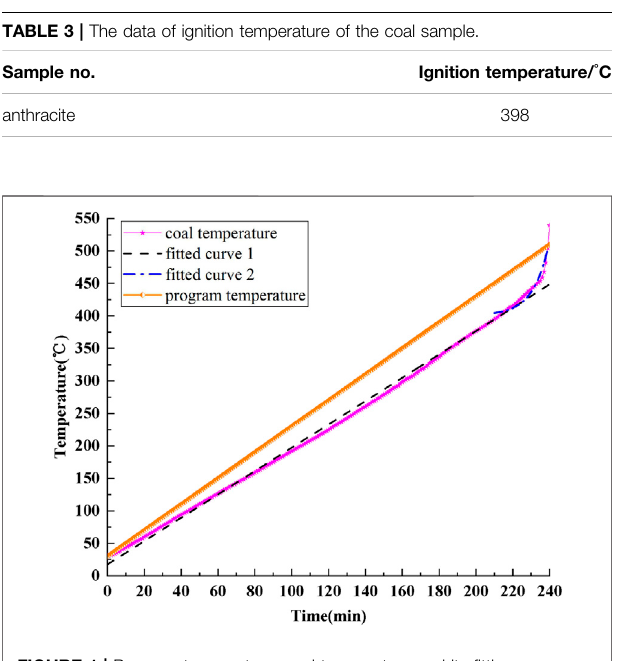
FIGURE 1 | Program temperature, coal temperature and its fi tting